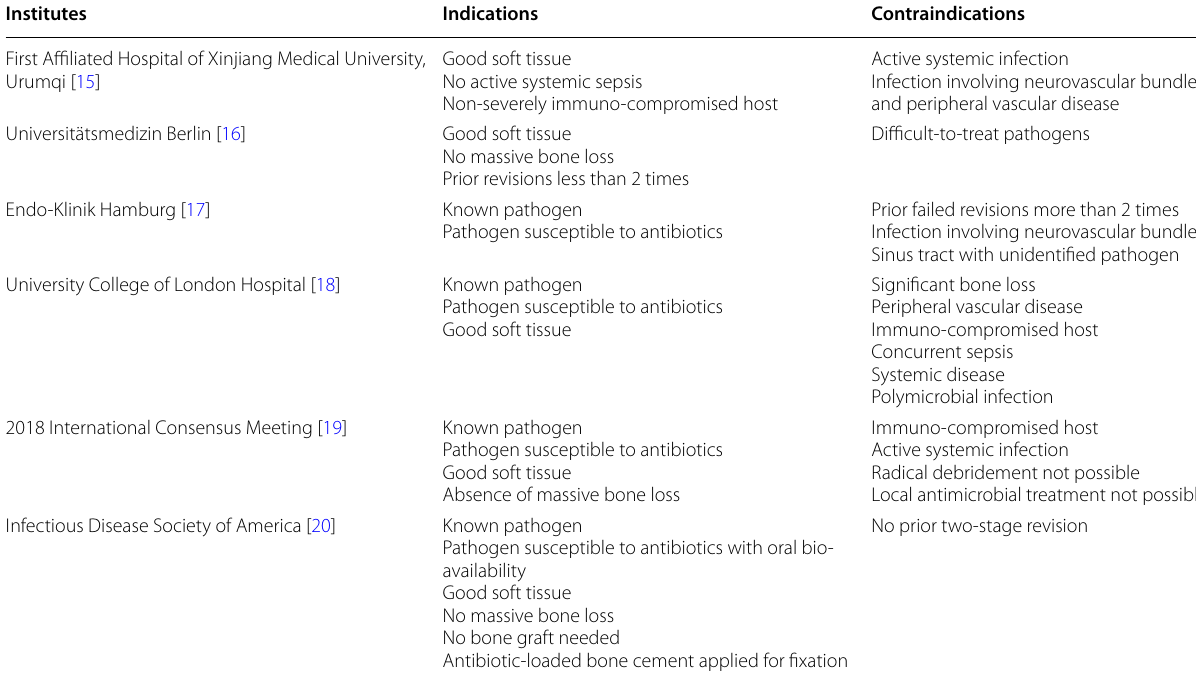
Table 1 Indications and contraindications for single-stage revision